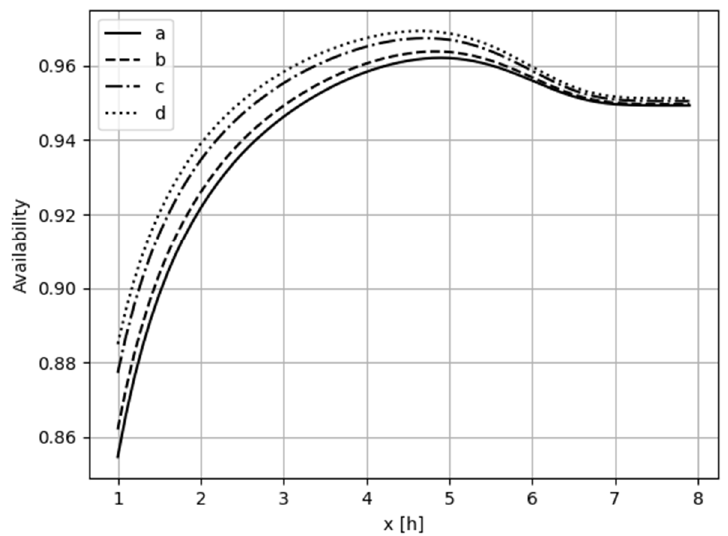
Figure 5. Graphs of the function g(x)—availability to carry out transport tasks in function of time to preventive replacement x [h], determined when the number of preventive replacements is as in the Example 1 (curve a) and when the number of preventive replacements is increased by 15%, 30% and 45%, respectively (curves b, c and d).